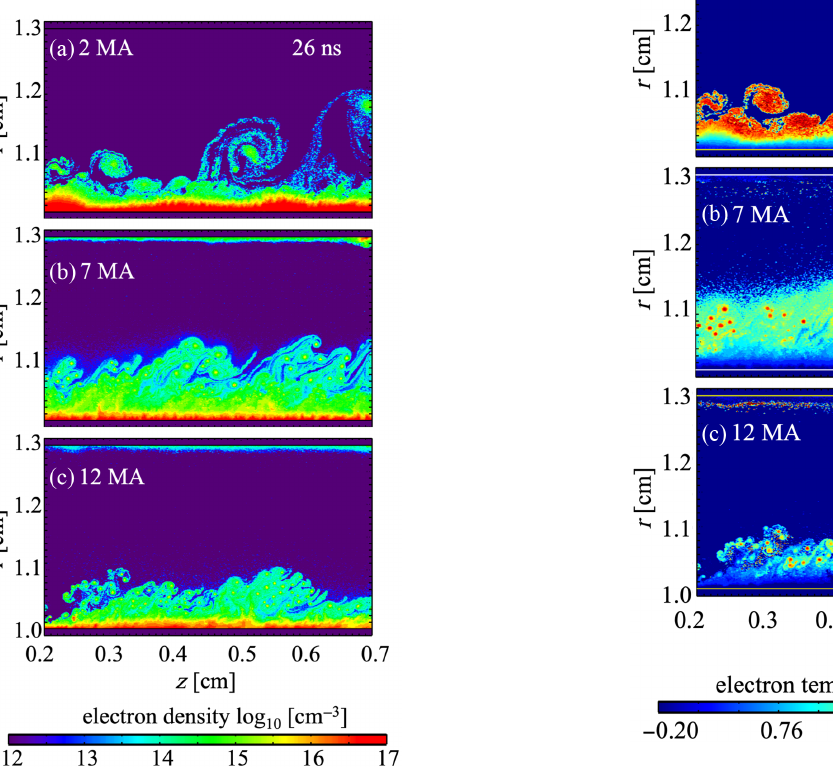
FIG. 5. The electron density contours in a 5-mm segment of the simulation illustrated in Fig. 1(b) at 26 ns reaching currents of (a) 2, (b) 7, and (c) 12 MA for the three pulse rises. Densities are plotted on a log scale from 10 12 – 10 17 .